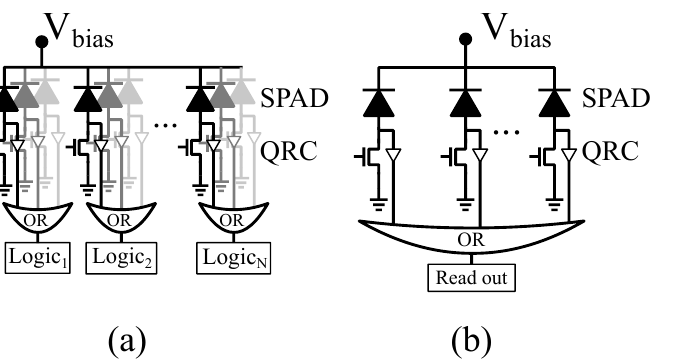
Figure 1. ( a ) Segmented digital silicon photomultiplier (SiPM) and ( b ) digital SiPM with com- mon readout.